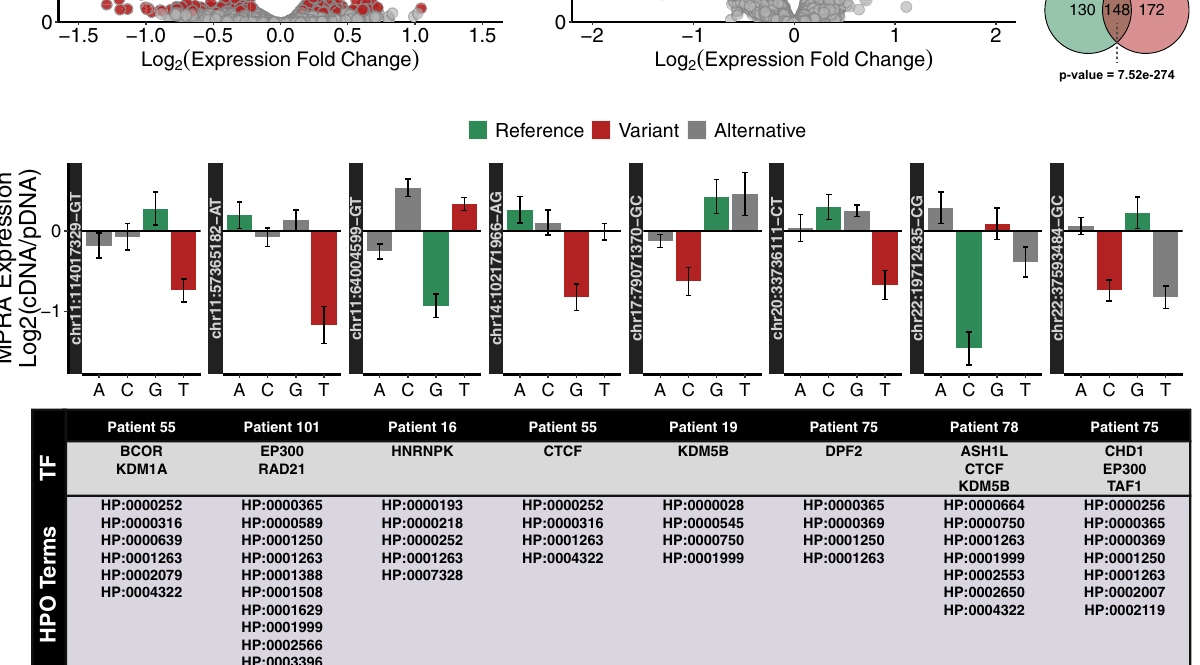
Figure 4. Integrative prediction of rare variant pathogenicity. ( a ) Significance analysis of HPO term overlap between probands and variant-associated transcription factors. ( b ) Schematic of transcription factor binding at candidate variant position. ( c ) MPRA analysis of candidate variant. ( d ) Volcano plot showing transcriptome- wide expression changes following CRISPRi-mediated repression of KDM5B. ( e ) Volcano plot showing transcriptome-wide expression changes following CRISPRi-mediated repression of variant site. ( f ) Significance analysis of overlapping expression changes following KDM5B or variant site repression. ( g ) MPRA analysis, transcription factor binding, and overlapping HPO terms for candidate